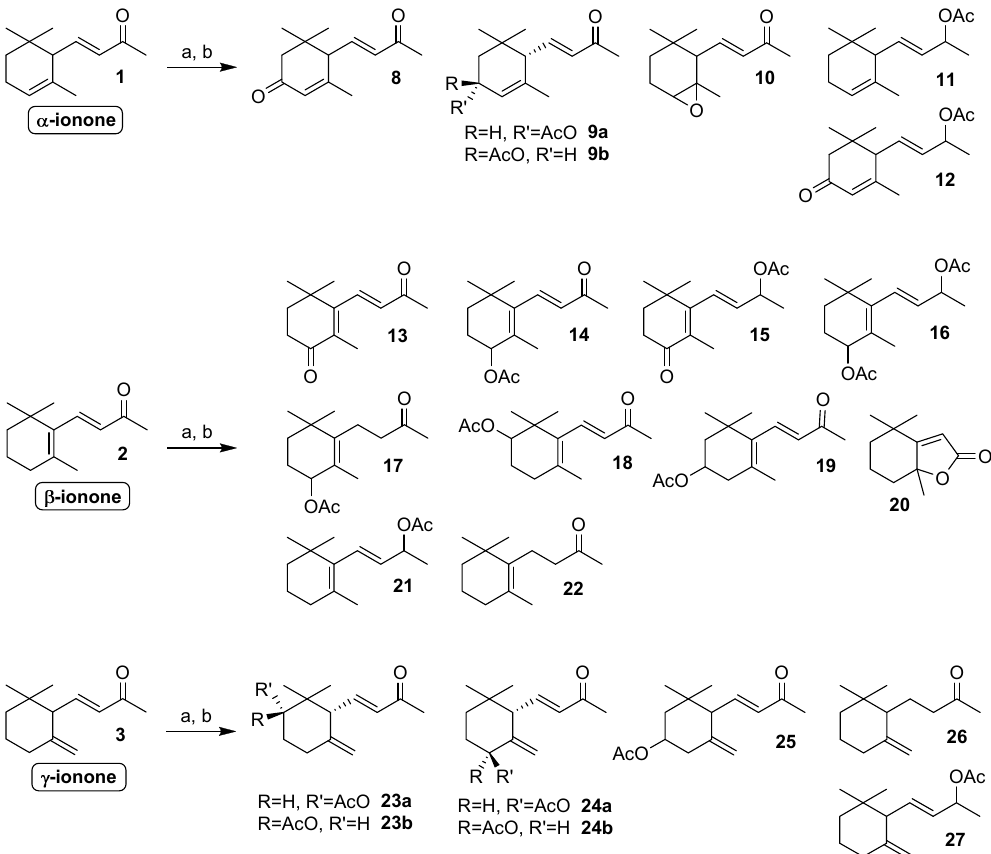
Figure 2. Compounds obtained through biotransformation of α -, β - and γ -ionone by means of the fungal strains employed in the present study. Reagents and conditions : ( a ) fungal strain, malt extract medium (MEM), aerobic conditions, 140 rpm, 20 or 25 ◦ C, 8–20 days; ( b ) Ac 2 O/pyridine